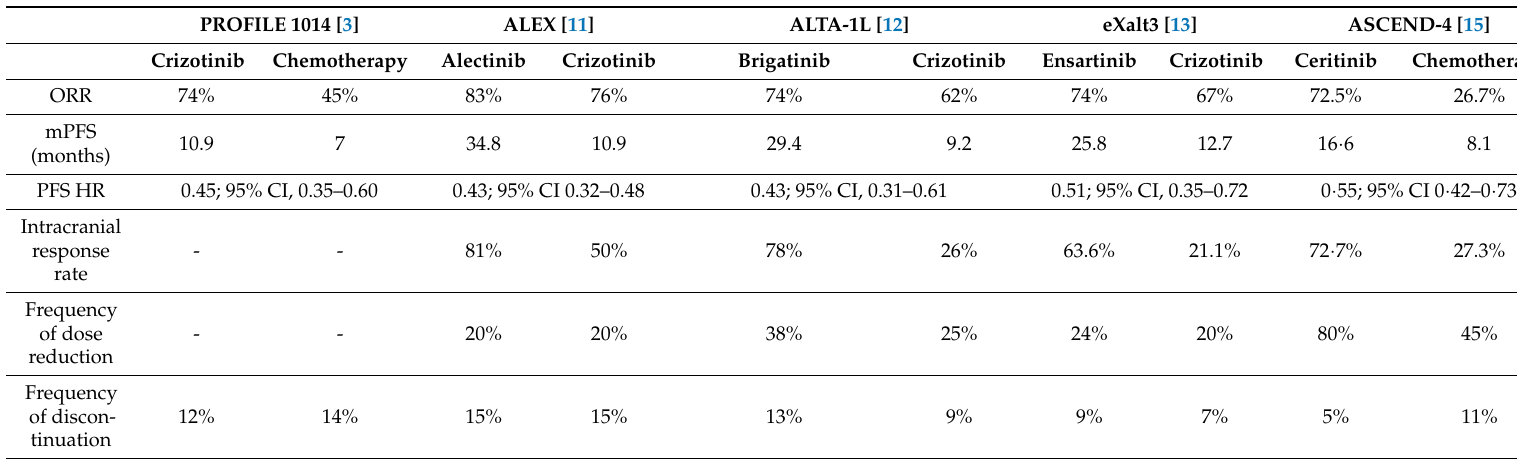
Table 3. Comparison of first-line phase III trials in advanced ALK-rearranged NSCLC